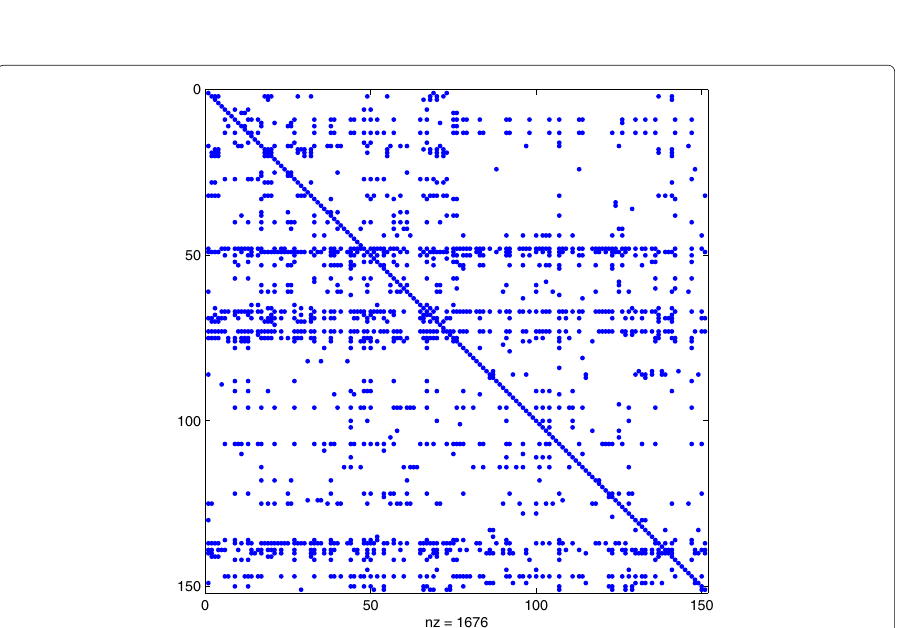
Fig. 5 Sparsity pattern. Enron: sparsity pattern of the final matrix (cid:12) Q [ M ] computed using (4) with α =